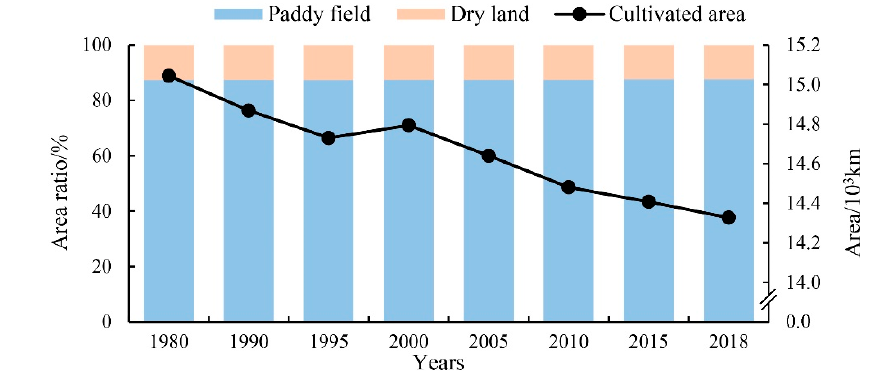
Figure 3. Change of cultivated land area in 1980–2018. Int. J. Environ. Res. Public Health 2020 , 17 , x FOR PEER REVIEW